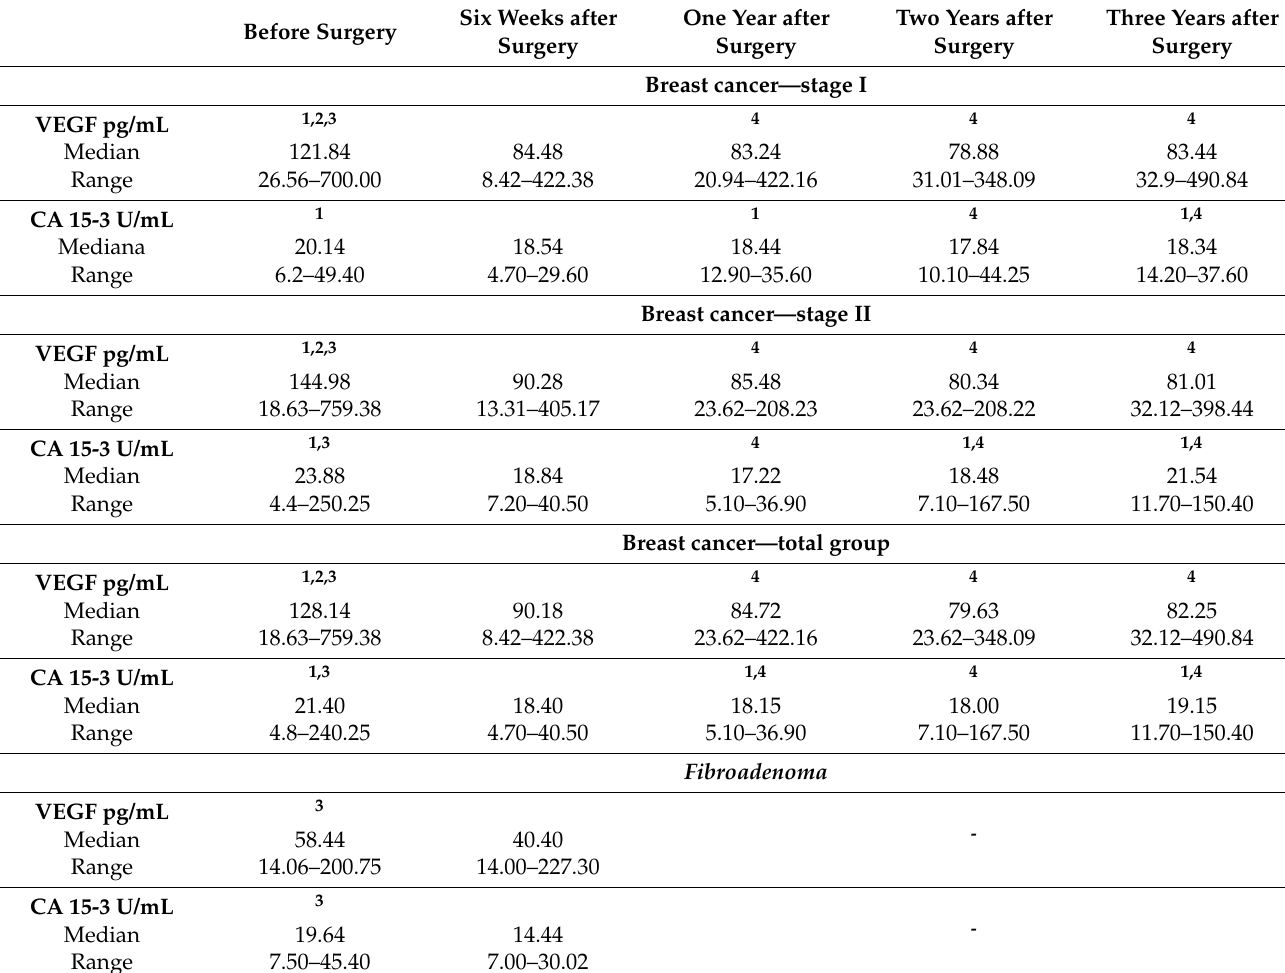
Table 2. Plasma levels of tested parameters in a three-year follow-up, groups according to the tumor stage of BC. Six Weeks after One Year after Two Years after Three Years after Before Surgery Surgery Surgery Surgery Surgery Breast cancer—stage